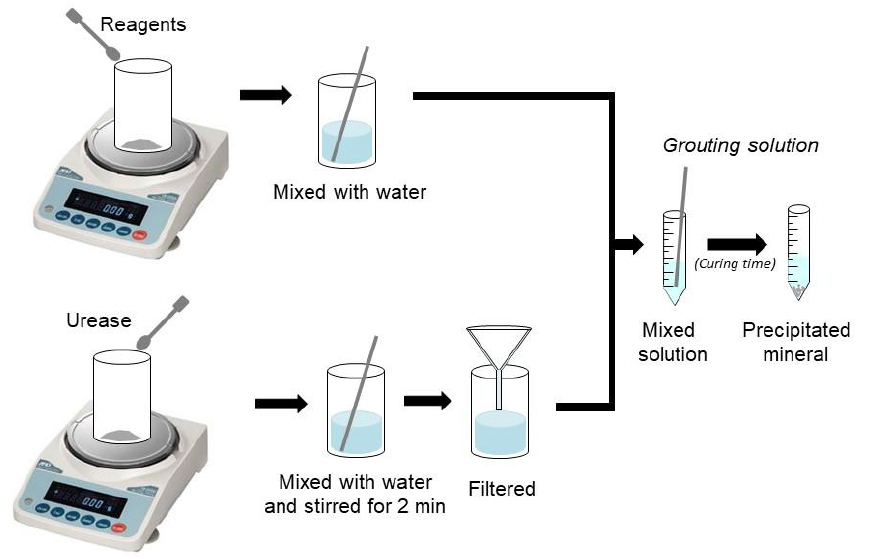
Figure 2. Procedure of the tube experiment [19,21].